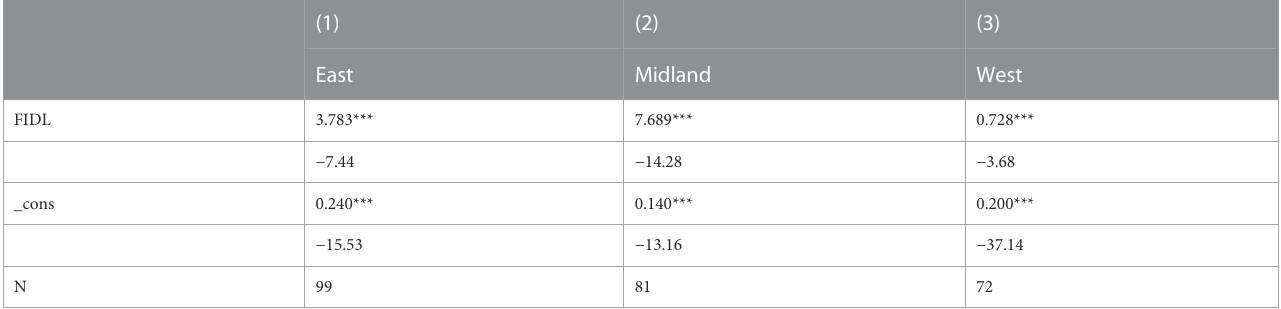
TABLE 8 Regression results based on Hypothesis 2 sub-region without the inclusion of control variables.